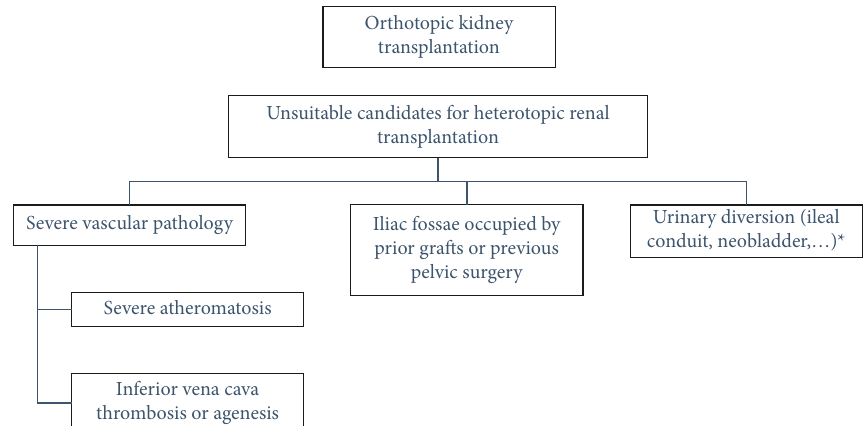
Figure 1: Indications for orthotopic kidney transplantation (OKT). ∗ OKT was used in kidney transplant recipients with a prior urinary diversion in our initial experience.